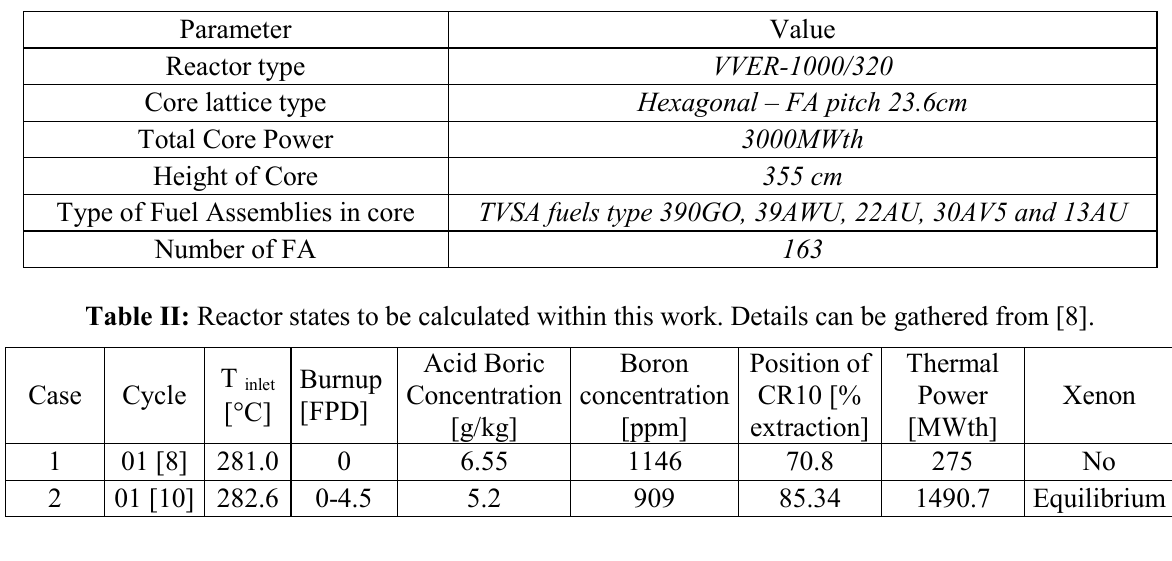
Table I: Main reactor data. Details can be gathered from [8].